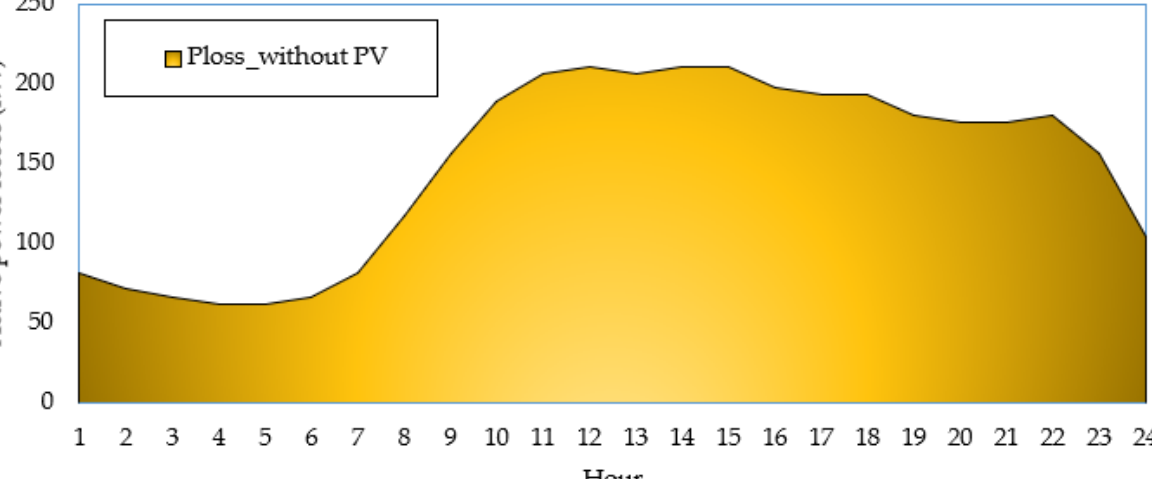
Figure 7. Hourly active power losses for the first scenario for the IEEE 33-distribution system.